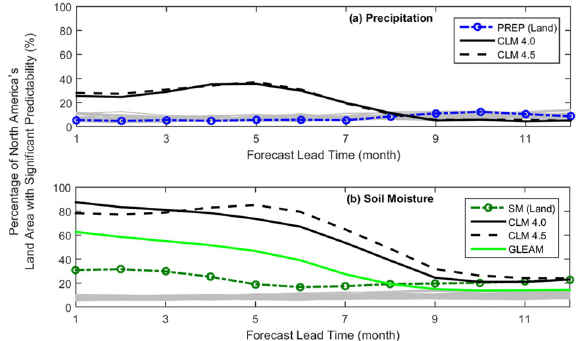
Fig. 6 The scope of improving the forecast skill by developing models that show comparable effect of the antecedent soil moisture on precipitation forecast as found in the observational estimates. Figure compares the effect of land initialization on precipitation and soil moisture forecasts in the CESM-DPLE with that of the observational estimates from CLM4 and CLM4.5. The fi gure shows anomaly correlations between initial condition total soil moisture anomalies and the ensemble average forecast (colored lines) or observations (black lines) in the respective experiments. The GLEAM root zone soil moisture data results is also